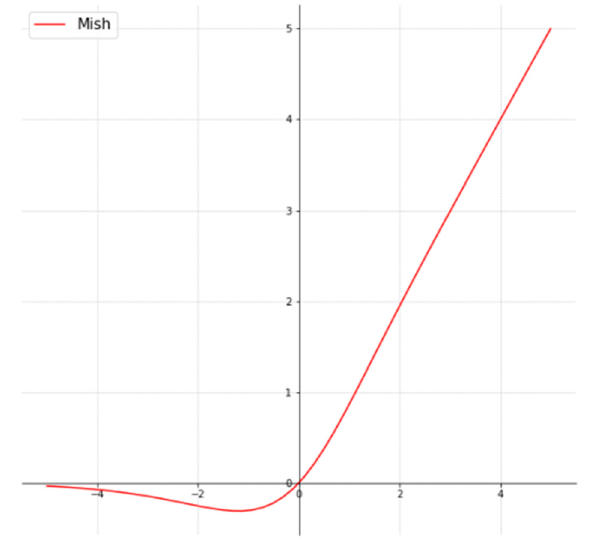
Figure 4. Mish Activation Function [16].